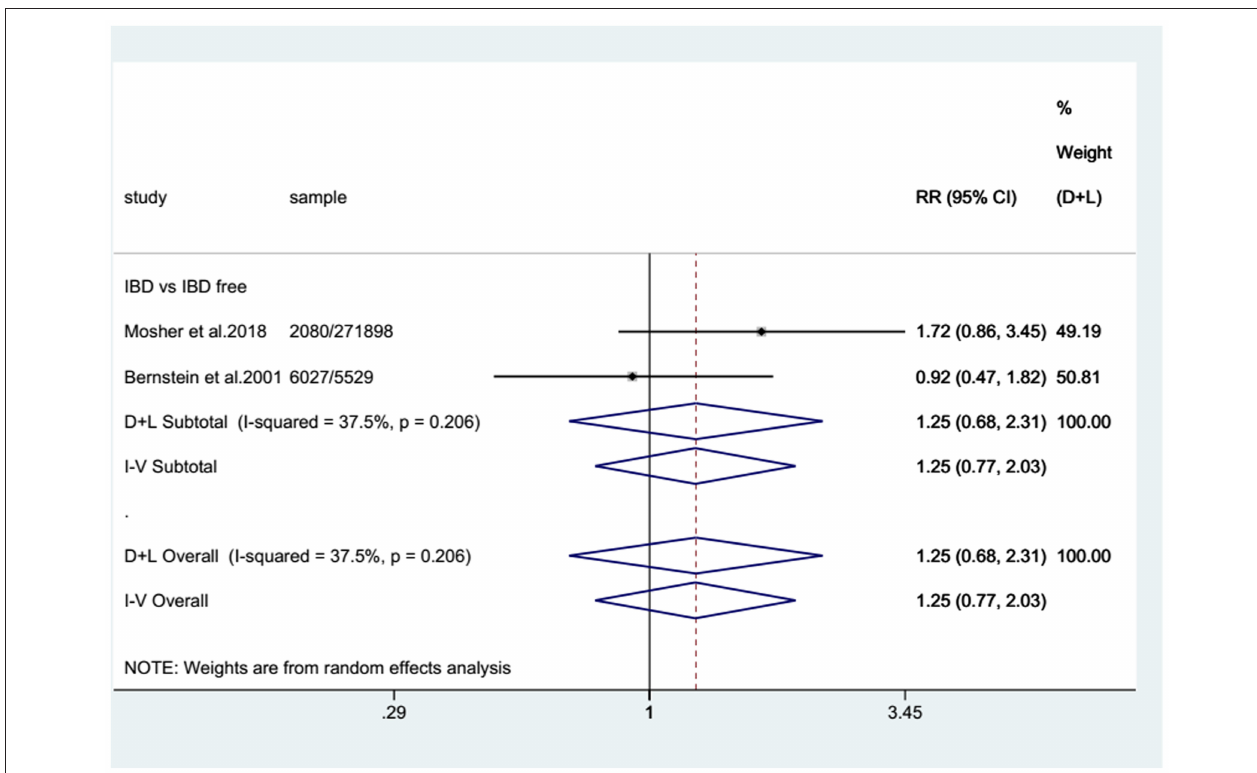
FIGURE 3 | Pooled relative risks (RRs) of eligible case-control studies. Forest plot showing the pooled RRs with 95% confidence intervals for bladder cancer occurrence in inflammatory bowel disease patients from the two eligible case-control studies. The size of the black boxes is proportional to the weight of the corresponding studies.